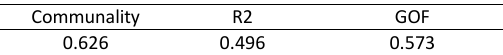
Table 9: Results of the overall model fit